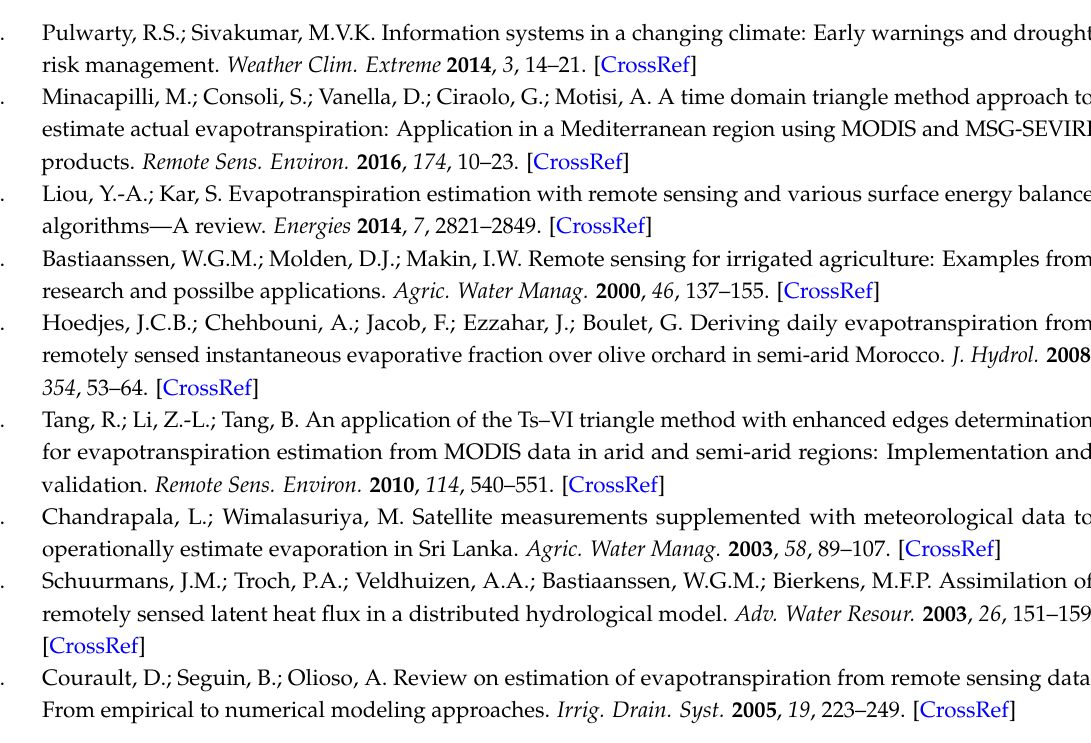
Figure A5. Monthly statistics of the slope ( a ) and intercept ( b ) of the dry edge estimated from the daily scatter plots from 2010 to 2012. Red dotted lines and yellow boxes highlight the summer season (June to August) of each year.